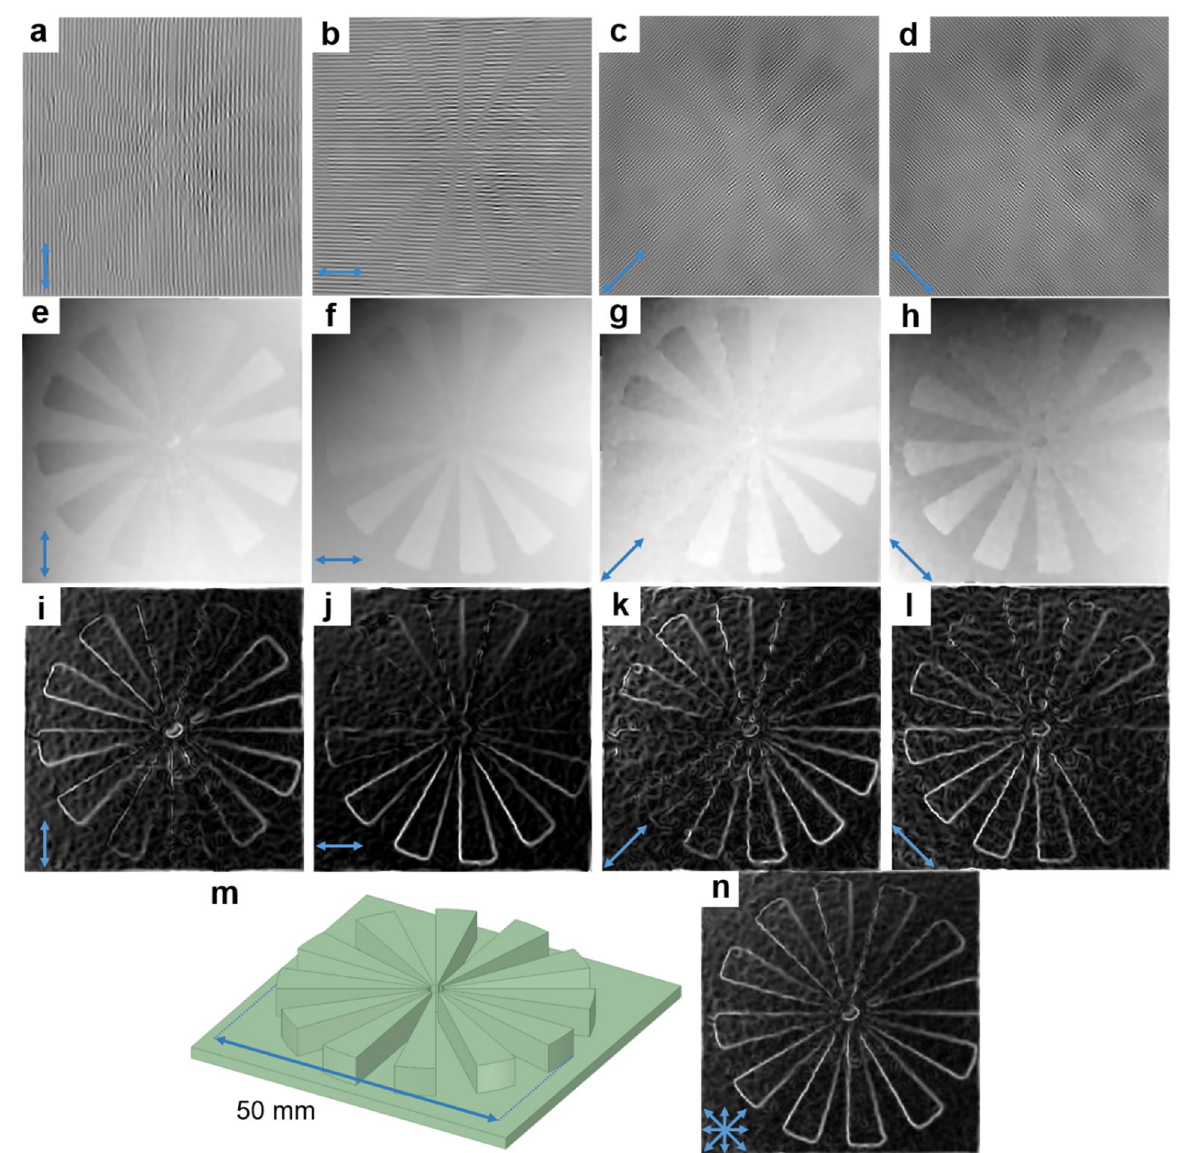
Figure 9. Evaluation of the sensitivity of fringe patterns based on direction. ( a – d ) DFPs in the vertical, horizontal, 45°, and 135° directions, respectively. ( e – h ) Unwrapped phase maps for DFPs. ( i – l ) Detected edge features with Sobel method for maps illustrated in ( e – h ), respectively. ( m ) CAD model of the target consisting of twelve spokes spaced 30° apart. ( n ) Result when combining edge features illustrated in ( i – l ). The arrows at the bottom left of each panel indicate the direction of the DFP used to reconstruct the corresponding phase